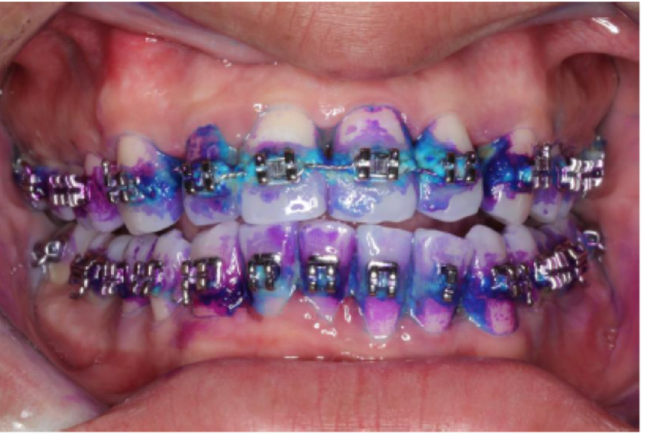
Figure 2. Use of the three-tone plaque disclosing gel, showing cariogenic, mature, and new dental biofilm as light blue, dark purple/blue, and pink/red stained areas, respectively.